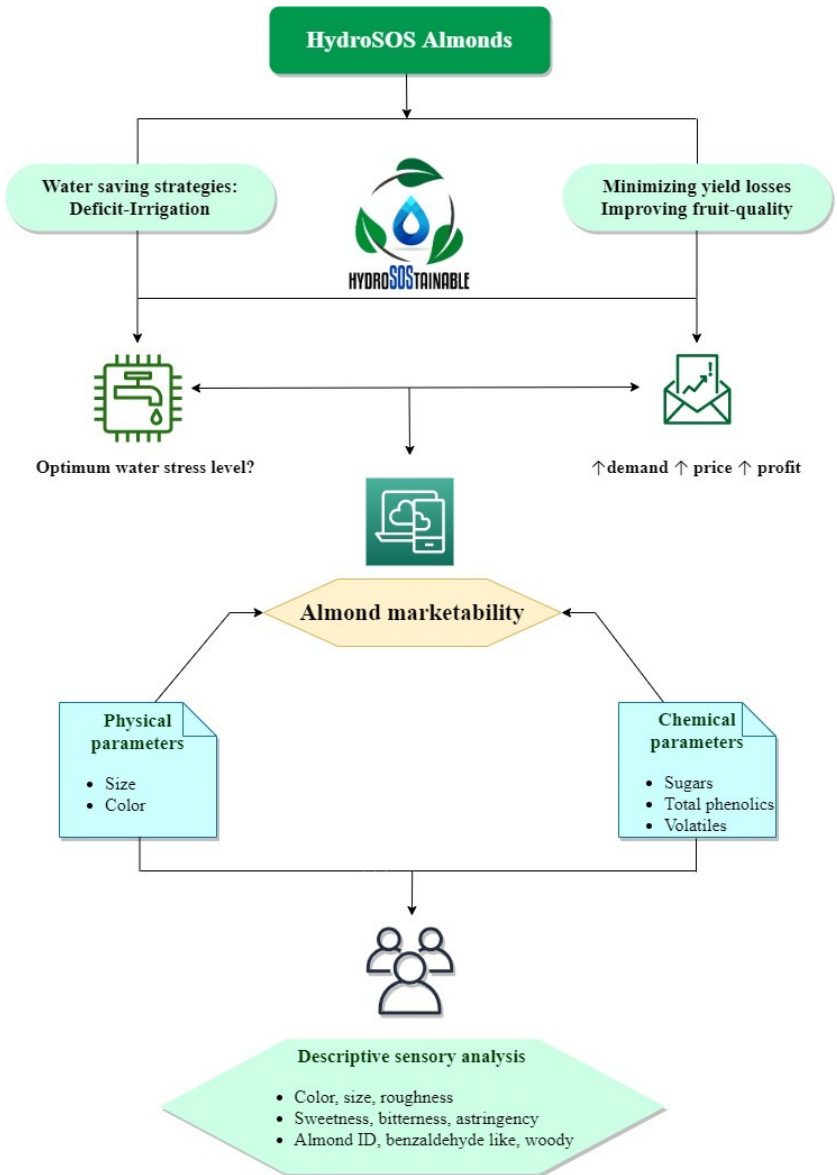
Figure 3. HydroSOStainable almonds: towards an equilibrium among water savings, optimum yields and quality parameters supported by marketability and sensory profile. ↑ ,